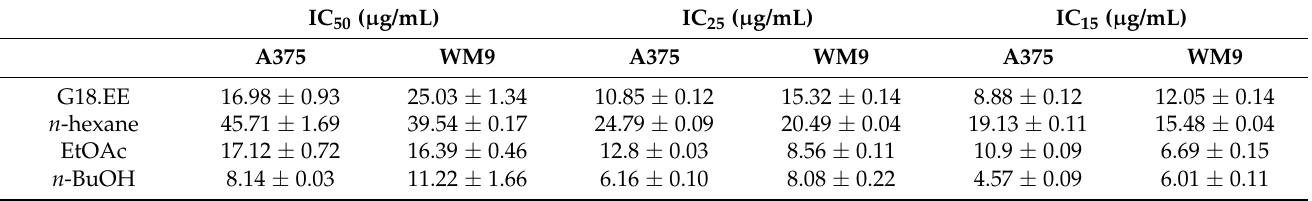
Figure 1. Effect of G18.EE and its fractions on total cell biomass of melanoma cells. A375 ( A ) and WM9 ( B ) cell lines were treated with a range of concentrations (5 to 60 µg/mL) of propolis extract (G18.EE) and its fractions ( n -hexane, EtOAc, and n -butanol) for 72 h. Cell biomass was measured by the Sulphorhodamine B (SRB) assay. Data were normalized for total biomass. Results represent the mean ± SD of three independent experiments carried out in triplicate. Table 2. IC 50 , IC 25 , and IC 15 values of the Portuguese propolis ethanol extract under study (G18.EE) and respective fractions ( n -hexane, EtOAc, and n -BuOH) against melanoma cell lines. A375 and WM9 cells were treated for 72 h with 5 to 60 µg/mL of each fraction. Results are expressed as mean ± SD.